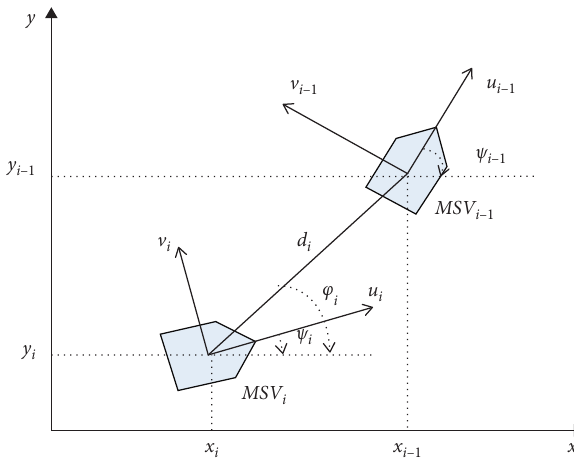
Figure 1: MSVs formation